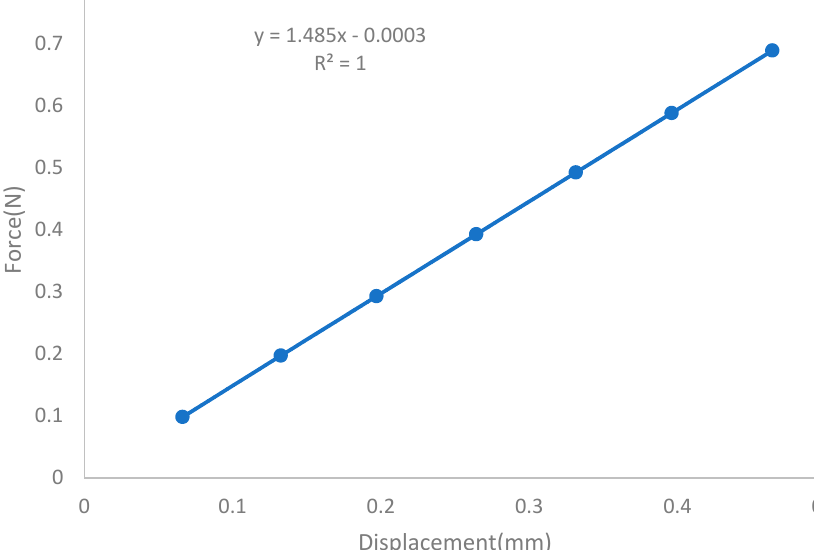
Figure 14. Experimental relationship between force and displacement.